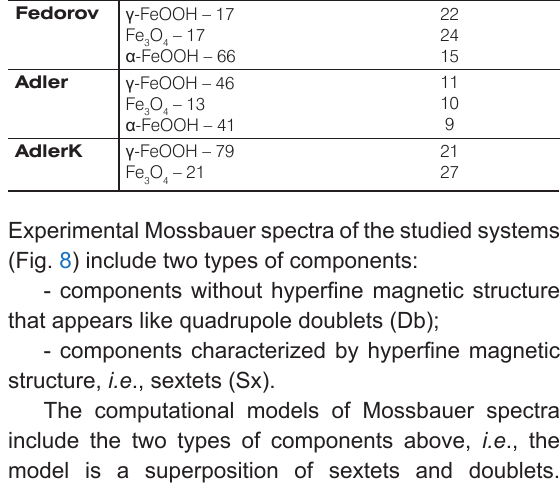
Table 4 . The parameters show presence of iron ions in different oxidation states and coordination and that they are included in different phases. According to the calculated Mossbauer parameters the following phases are identified in the samples: γ - FeOOH (lepidocrocite), α - FeOOH (goethite), Fe O (magnetite), γ - Fe O 3-x 4 2 3 (maghemite).